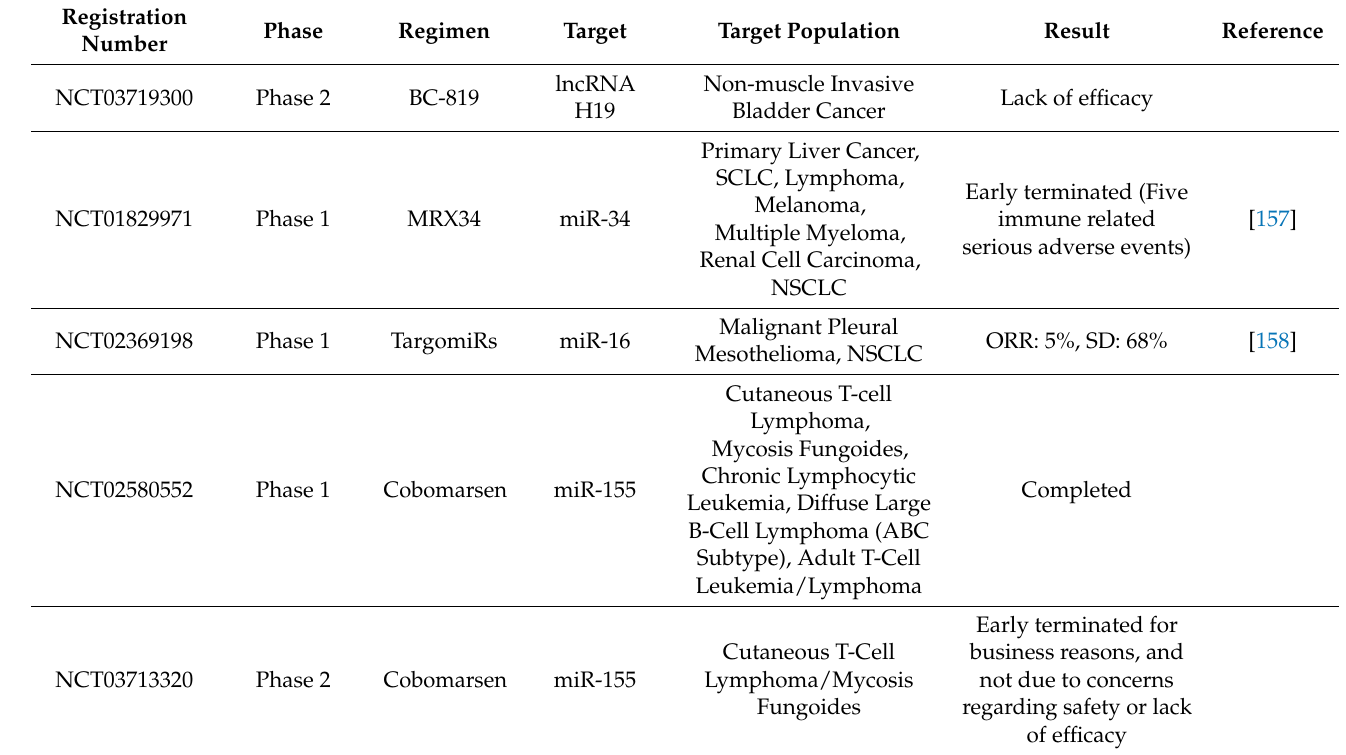
Table 5. LncRNA-based or miRNA-based therapy clinical trials in